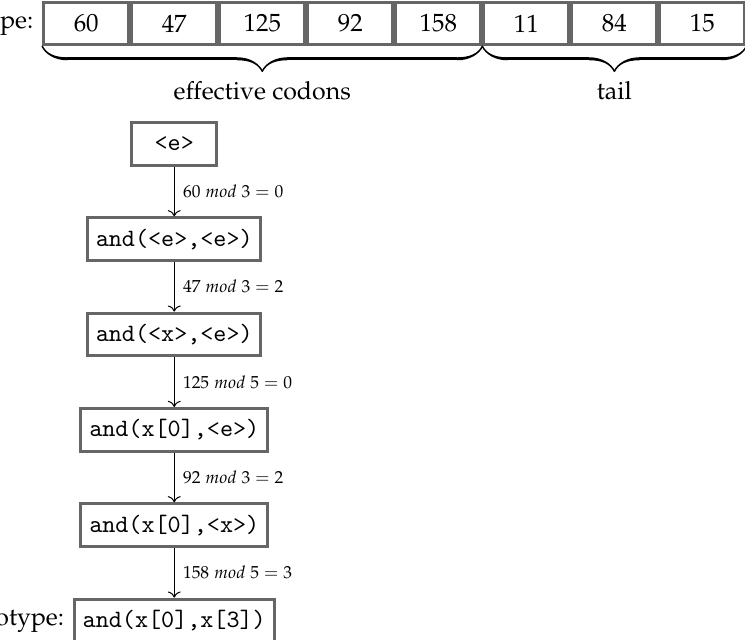
Figure 2. Example of a genotype being mapped into its respective